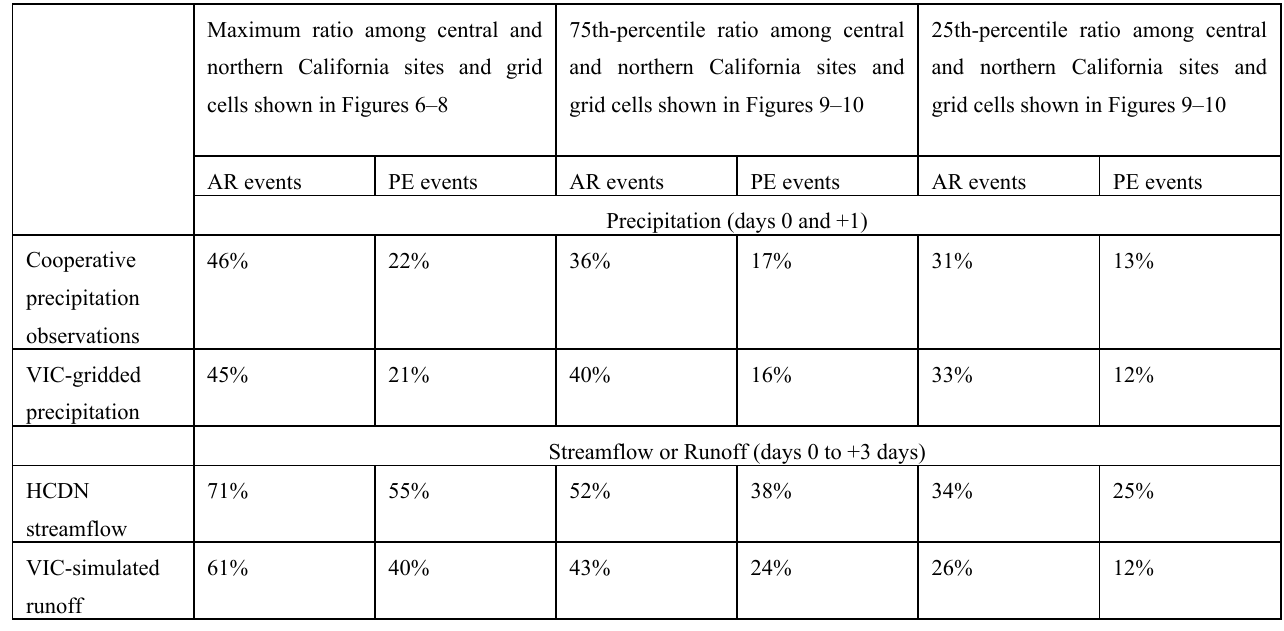
Table 3. Ratios of precipitation and streamflow or runoff during AR and PE events, and subsequent days (as indicated), to overall precipitation, streamflow or runoff, among cooperative precipitation sites and VIC-gridded precipitation data, and streamflow or runoff, among HCDN streamflow gauging stations and gridded VIC simulations, respectively, in central and northern California (east of 120° W and south of 42° N). See section 2 for descriptions of data